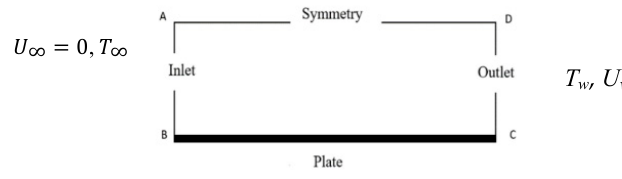
Figure 5. The flow configuration.